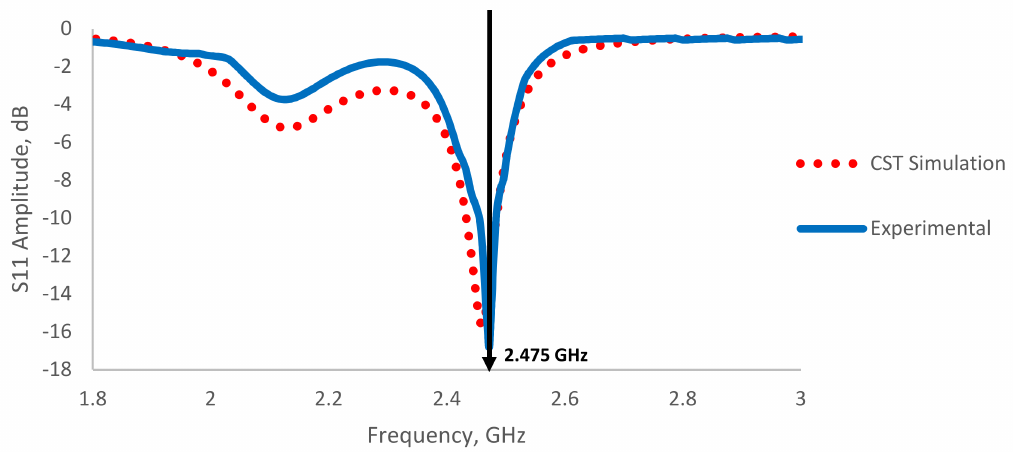
Figure 13. Comparison between experimental and CST simulation results of patch antenna in exposure to air